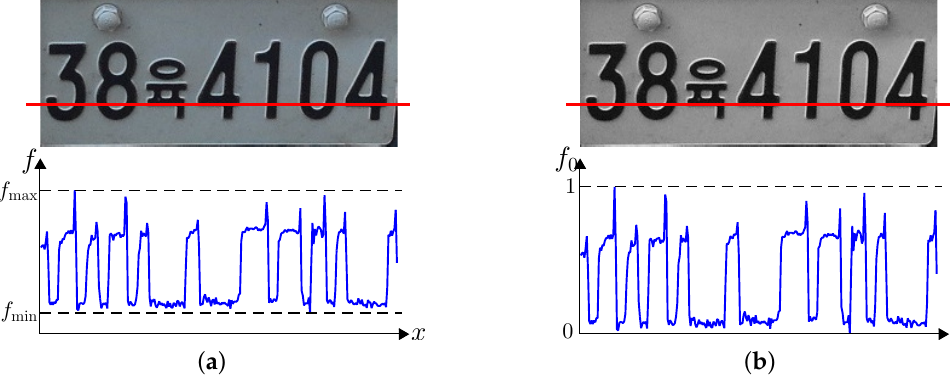
Figure 2. ( a ) Given image f and ( b ) normalized grayscale image f 0